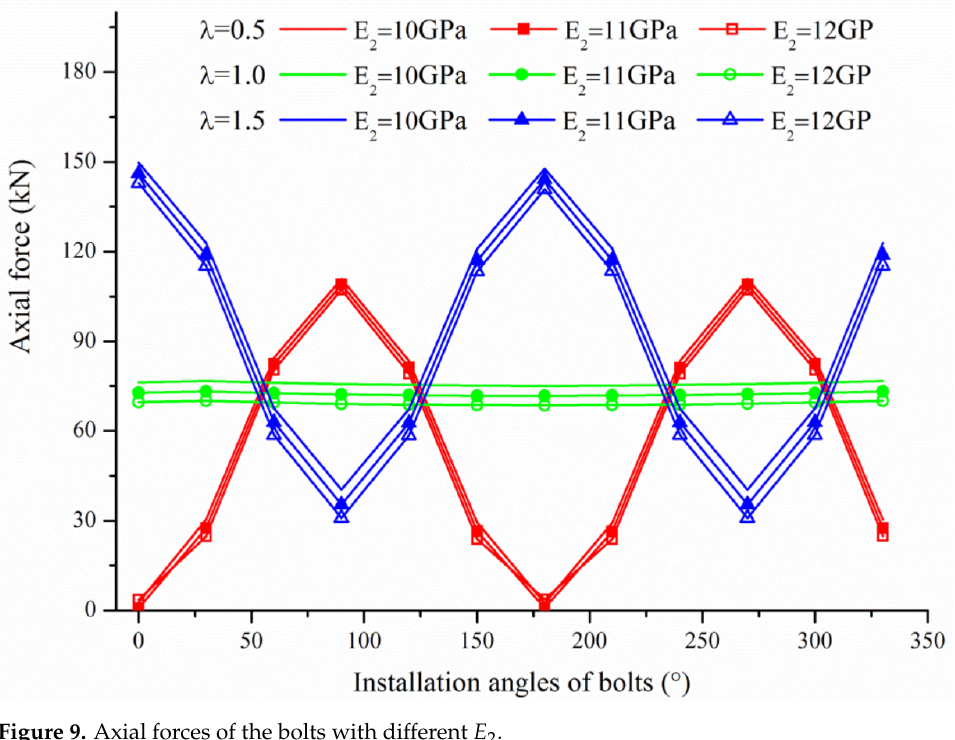
Figure 9. Axial forces of the bolts with different E 2 .